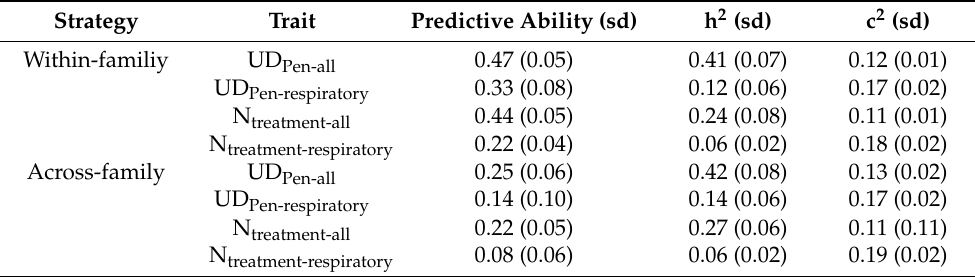
Table 4. Cross-validation results for within-family and across-family cross-validation. Estimates of predictive abilities (correlation of EBVs from validation dataset with corrected phenotypes), heritabilities (h 2 ) and common environmental effects (c 2 ) are